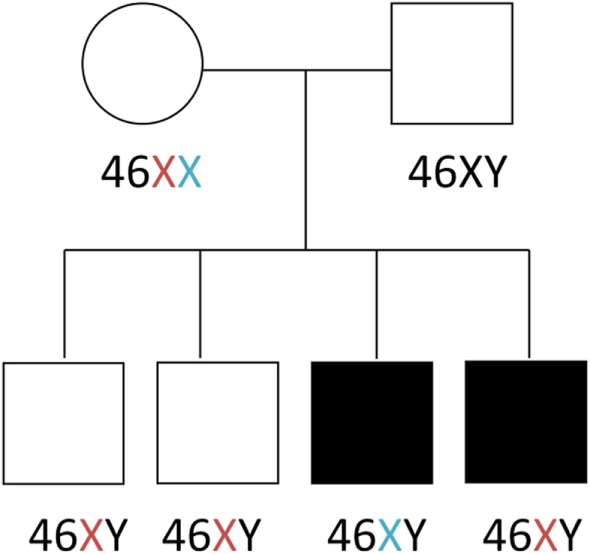
Family pedigree.